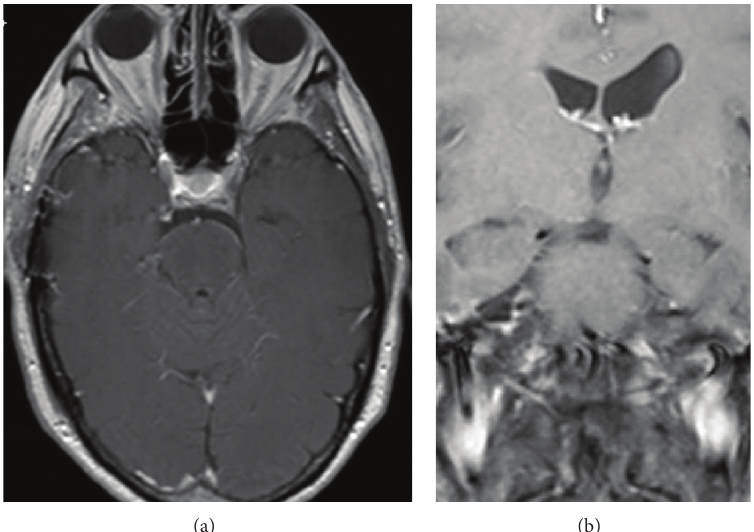
Figure 3: Postoperative MRI brain with contrast axial (a) and coronal (b) T1-weighted images reveals complete resection of the trochlear